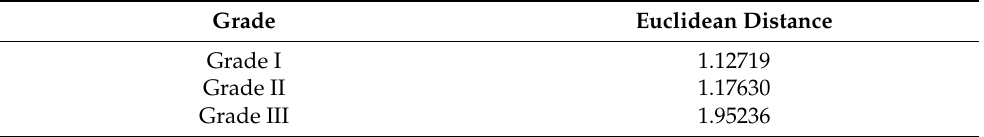
Table 18. Euclidean distances between new samples’ principal components and the average values for each